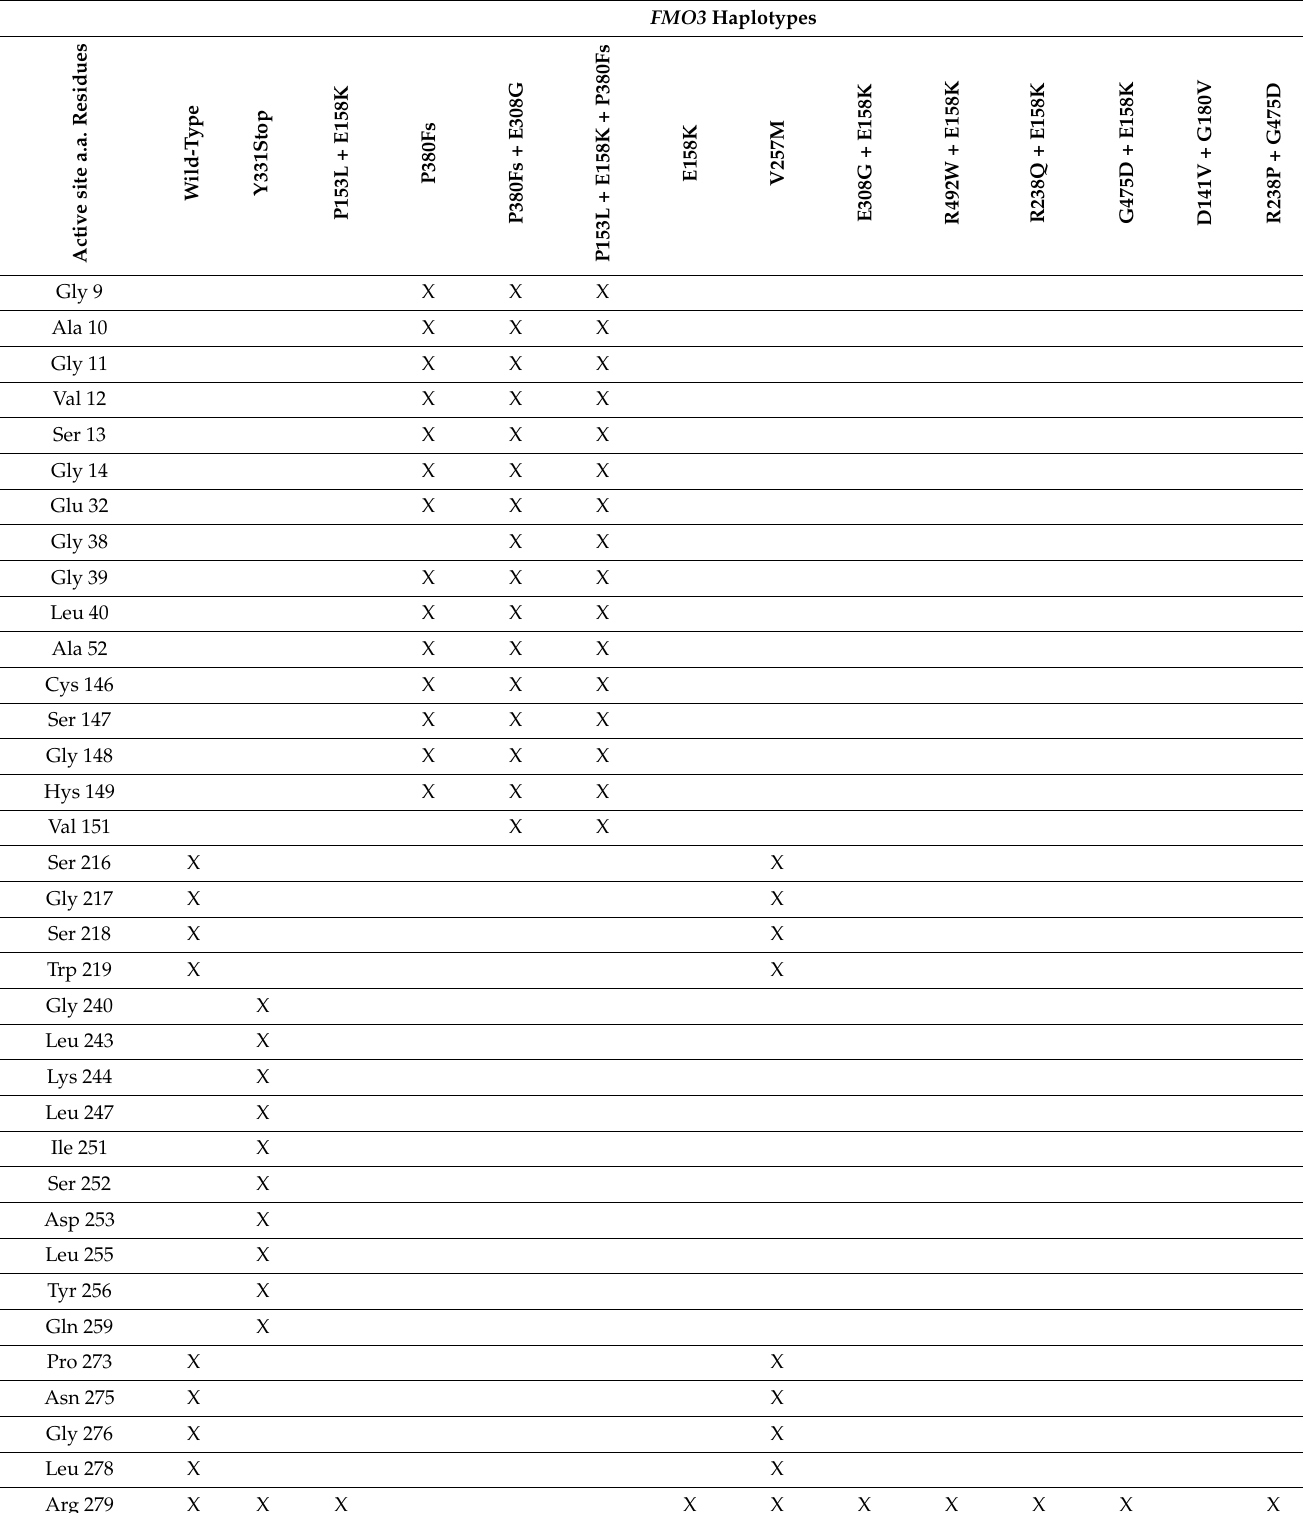
Table 5. Mutated FMO3 showed different amino acids predicted for the TMA binding sites. Different haplotypes present in the mutated forms of FMO3 were predicted to change the aa characteristic of wild-type enzyme catalytic site, probably leading to an impairment of FMO3 activity. The “X” indicates that the specific aa in the related row is an integral part of the FMO3 active site when the variant/s reported in the columns is/are carried by the FMO3